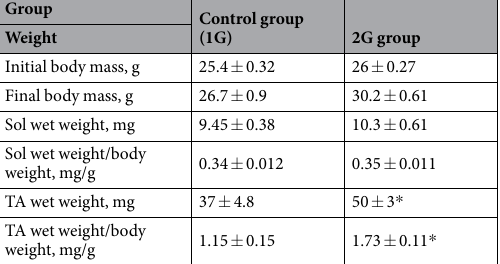
Table 1. Body mass and absolute and body mass-adjusted wet weights of the soleus (Sol) and tibialis anterior (TA) muscles. Values are means ± SEM.; n = 8/group. * Significant difference vs . Control, p <